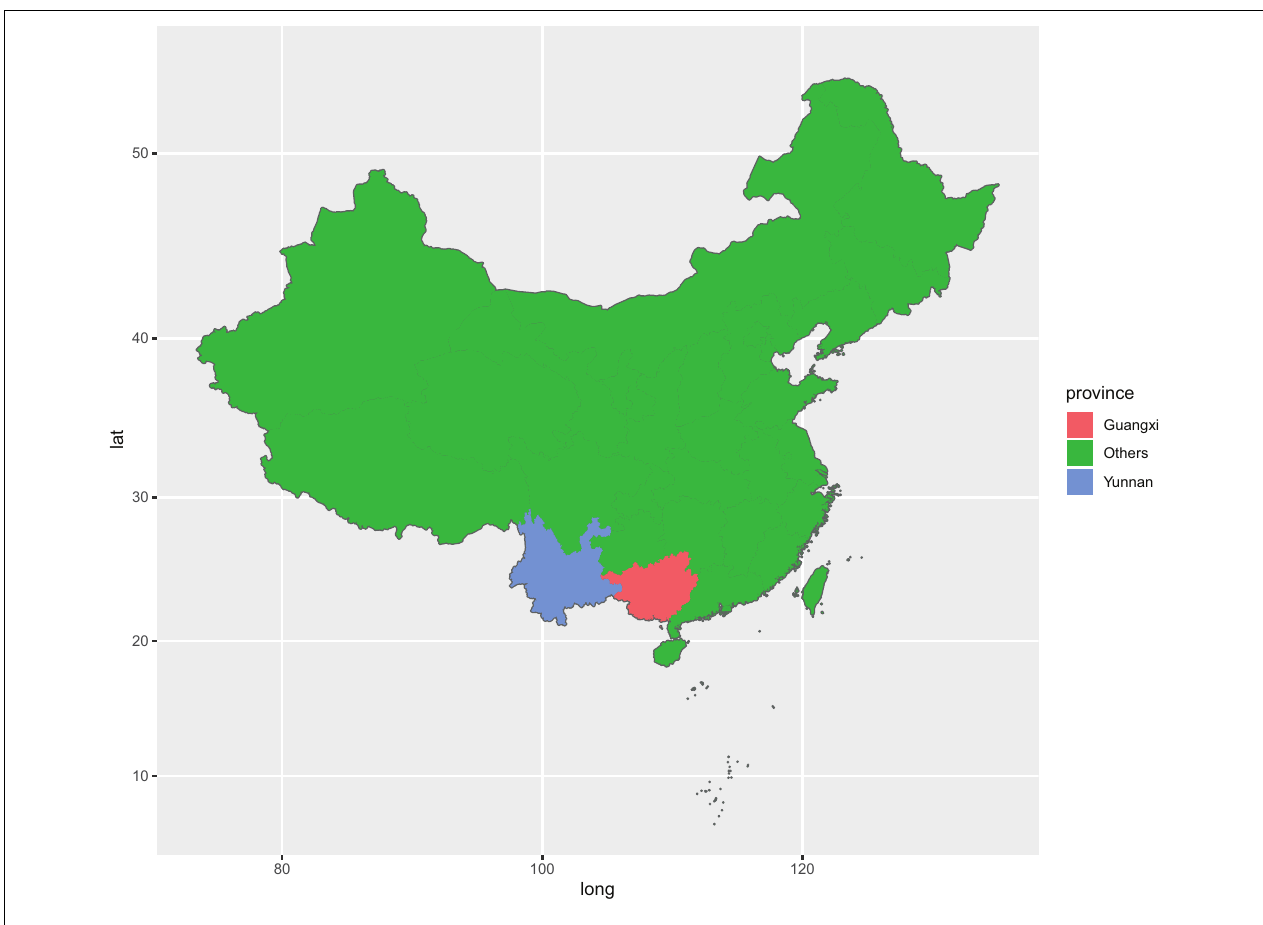
FIGURE 1 | Geographic distribution of sampling sites across the main producing areas of Panax.